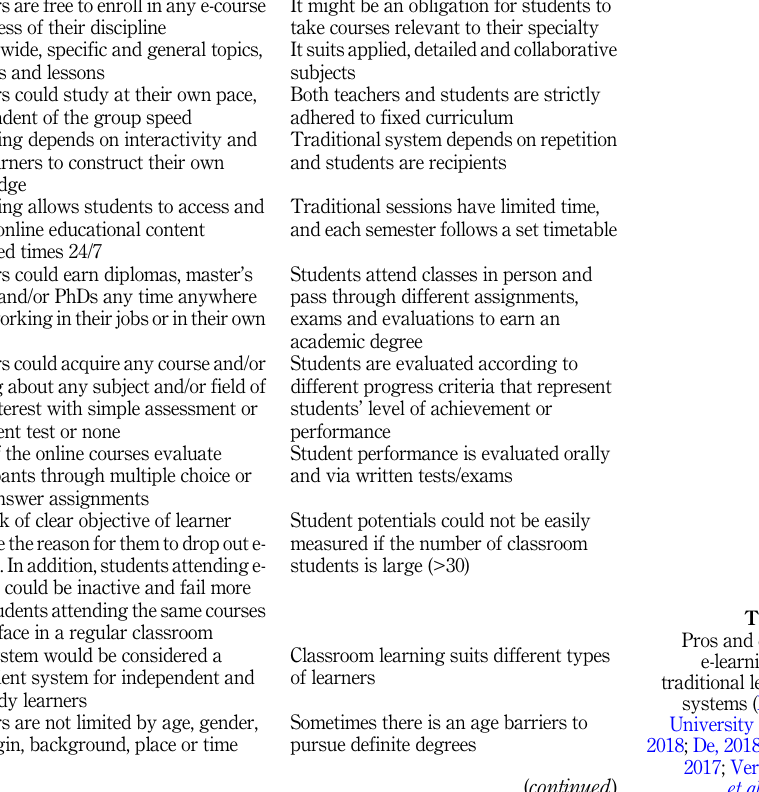
Table I. Pros and cons